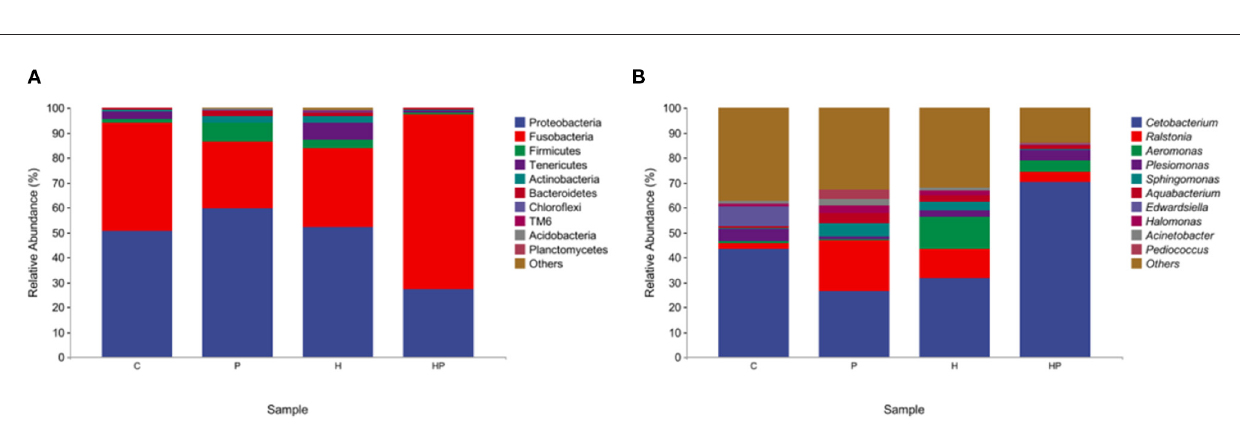
enriched in H group, represented as the biomarker species induced by HFD (Supplementary Figure 2A). Cetobacterium and Pediococcus were enriched in HP and P groups, respectively. Compared to H group, Cetobacterium and Pediococcus were enriched in HP group, represented as the biomarker species induced by probiotic